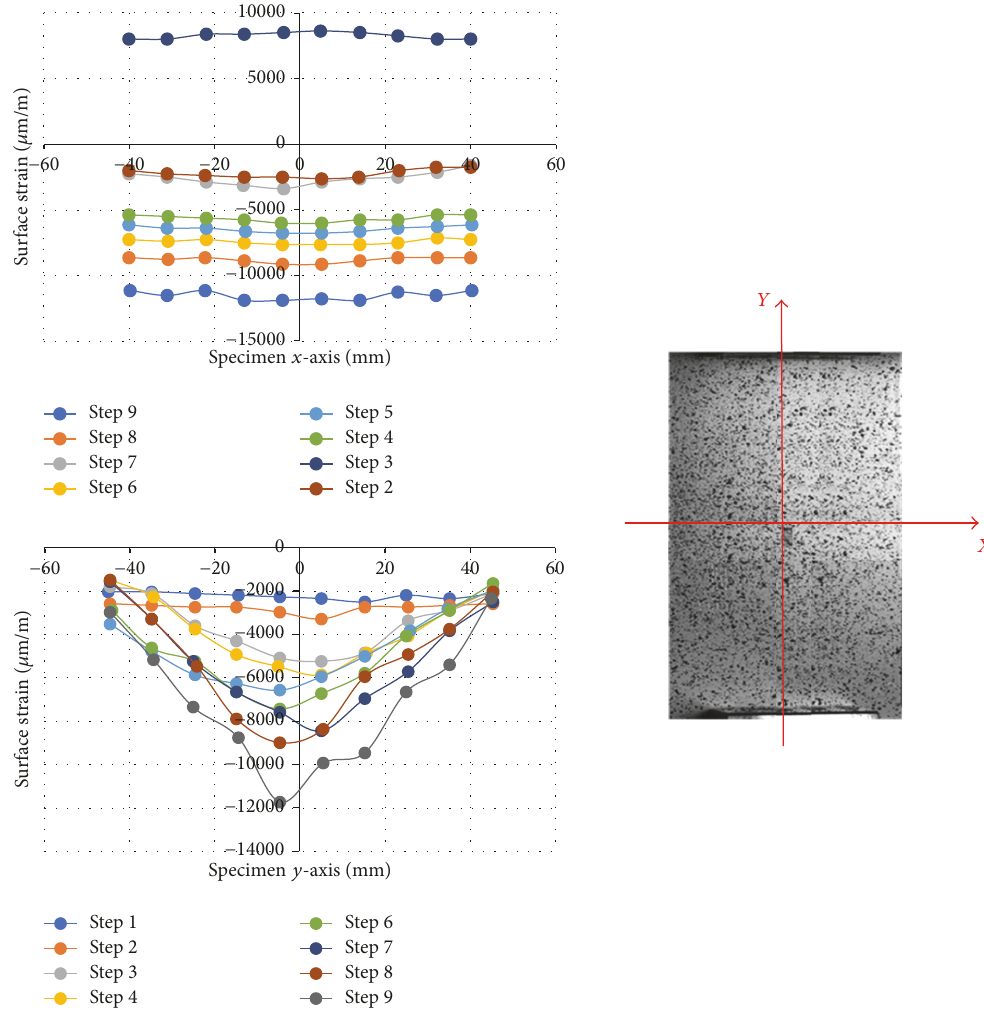
Figure 14: Surface strain-principal values along symmetry axes-central delamination specimen.